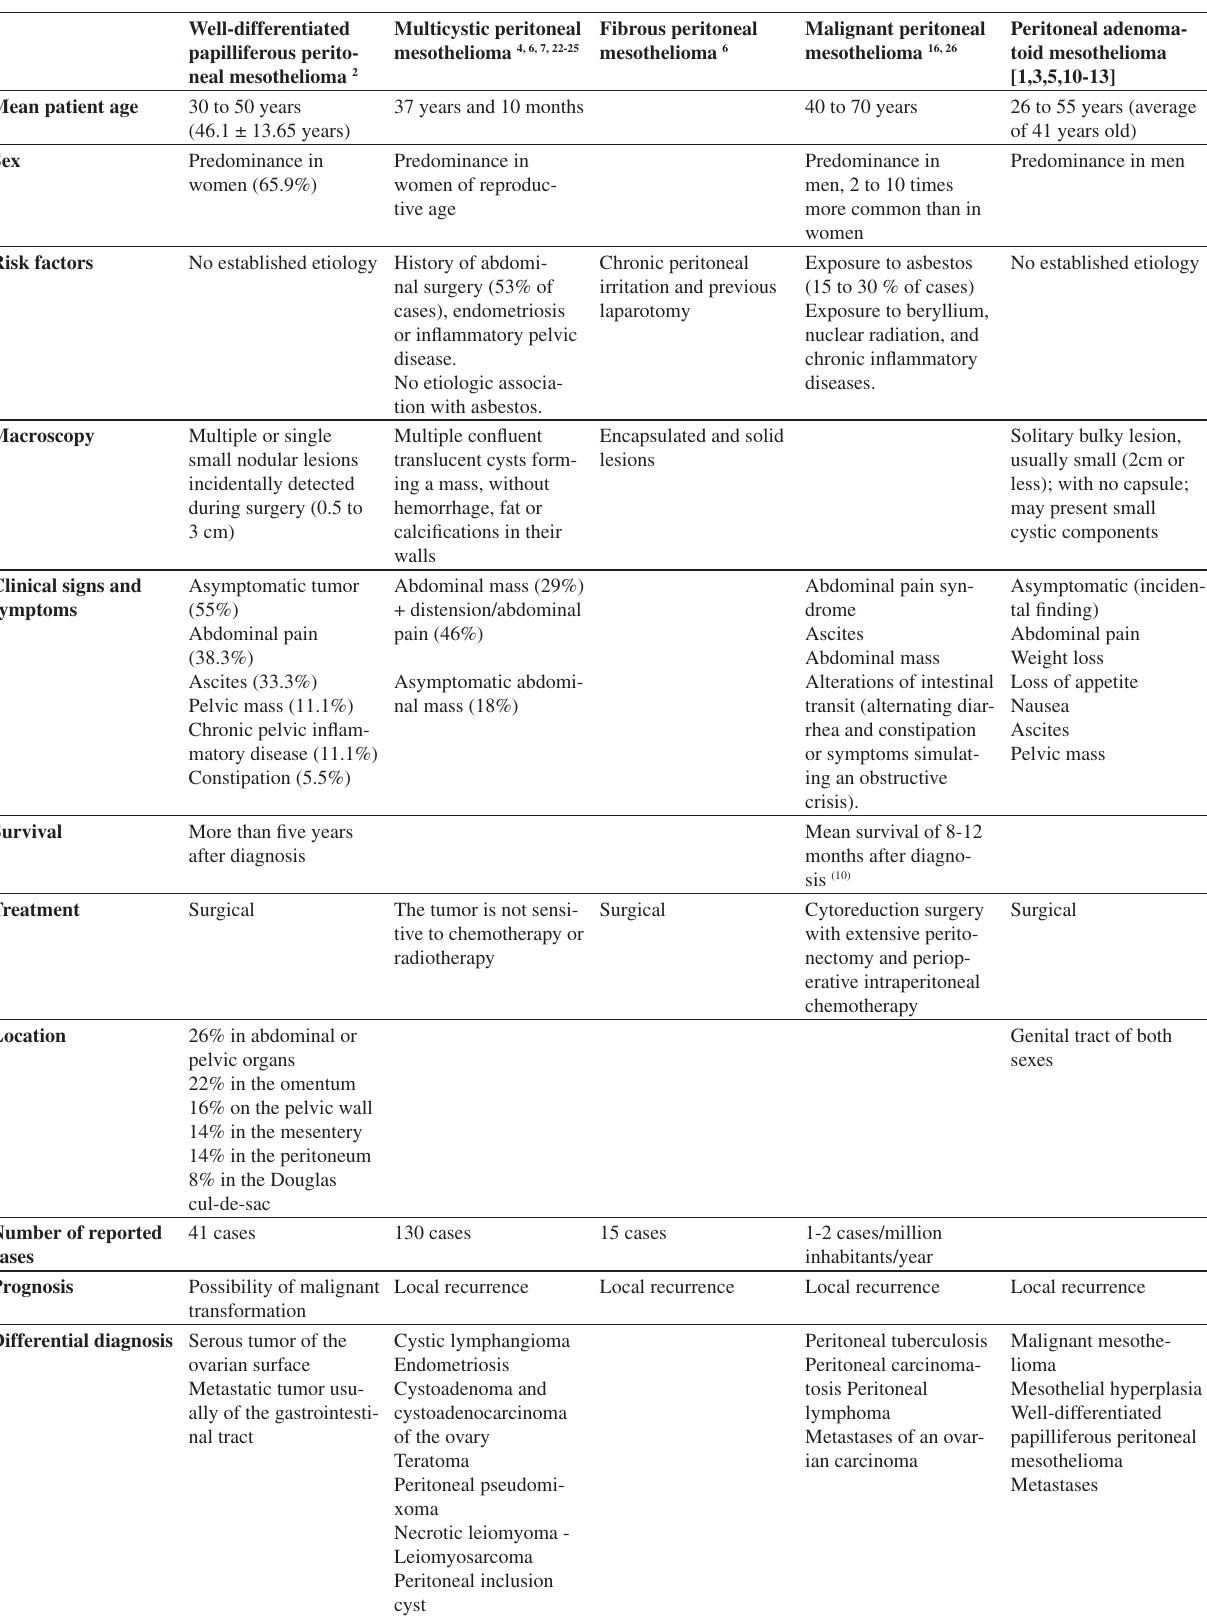
Table 2 - Features of mesothelioma-type tumors as reported in the